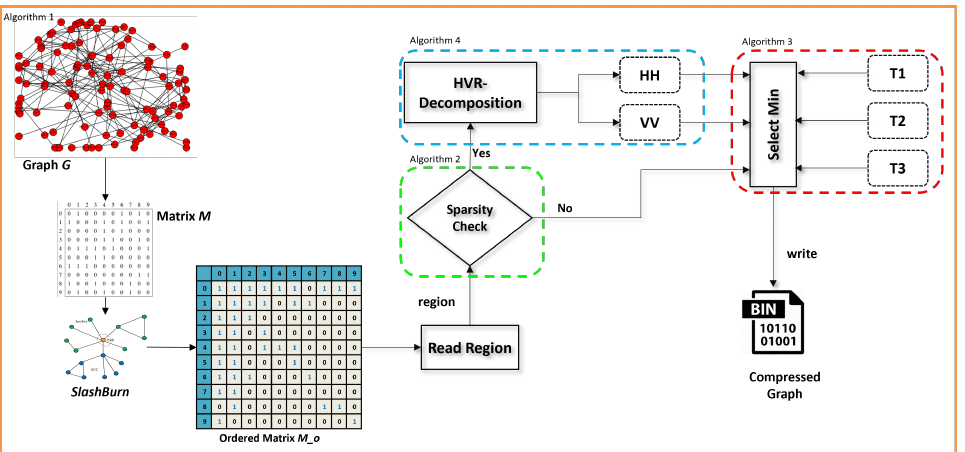
Figure 5. Detailed architecture of the proposed methodology. HH , VV are different shapes and T 1, T 2, T 3 are the template